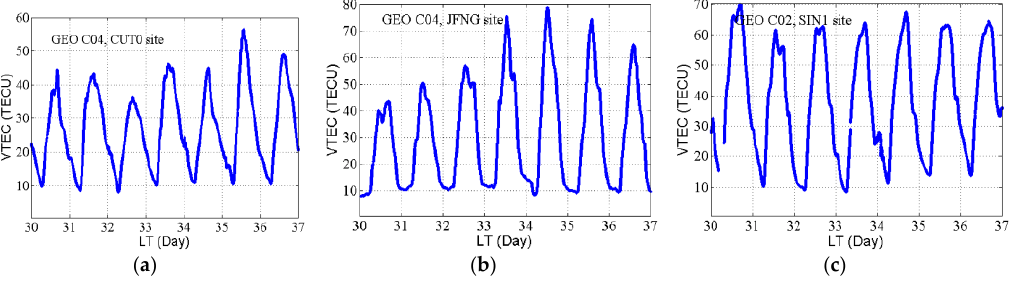
Figure 7. Day-to-day variation of VTEC derived from GEO satellites on Days 30–36/2014. CUT0 ( a ), JFNG ( b ), SIN1 ( c ).